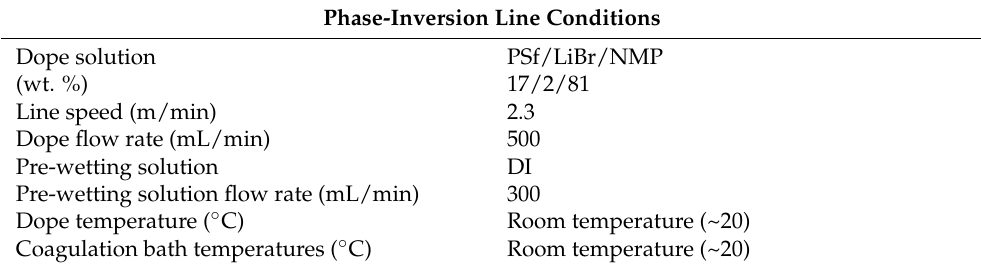
Table 1. Casting conditions for industrial-scale production of reinforced flat-sheet membranes.